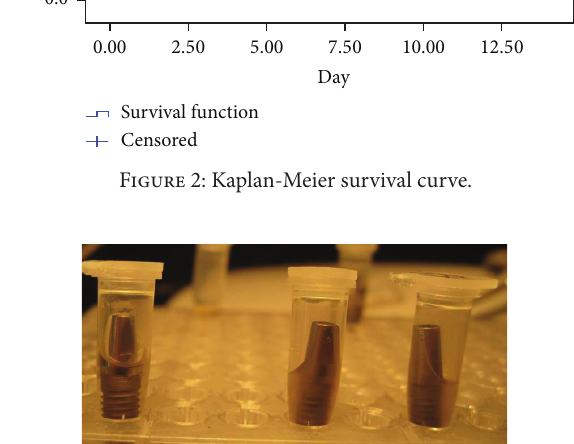
Figure 3: The samples from butt joint connection group with (two samples on the right side) and without